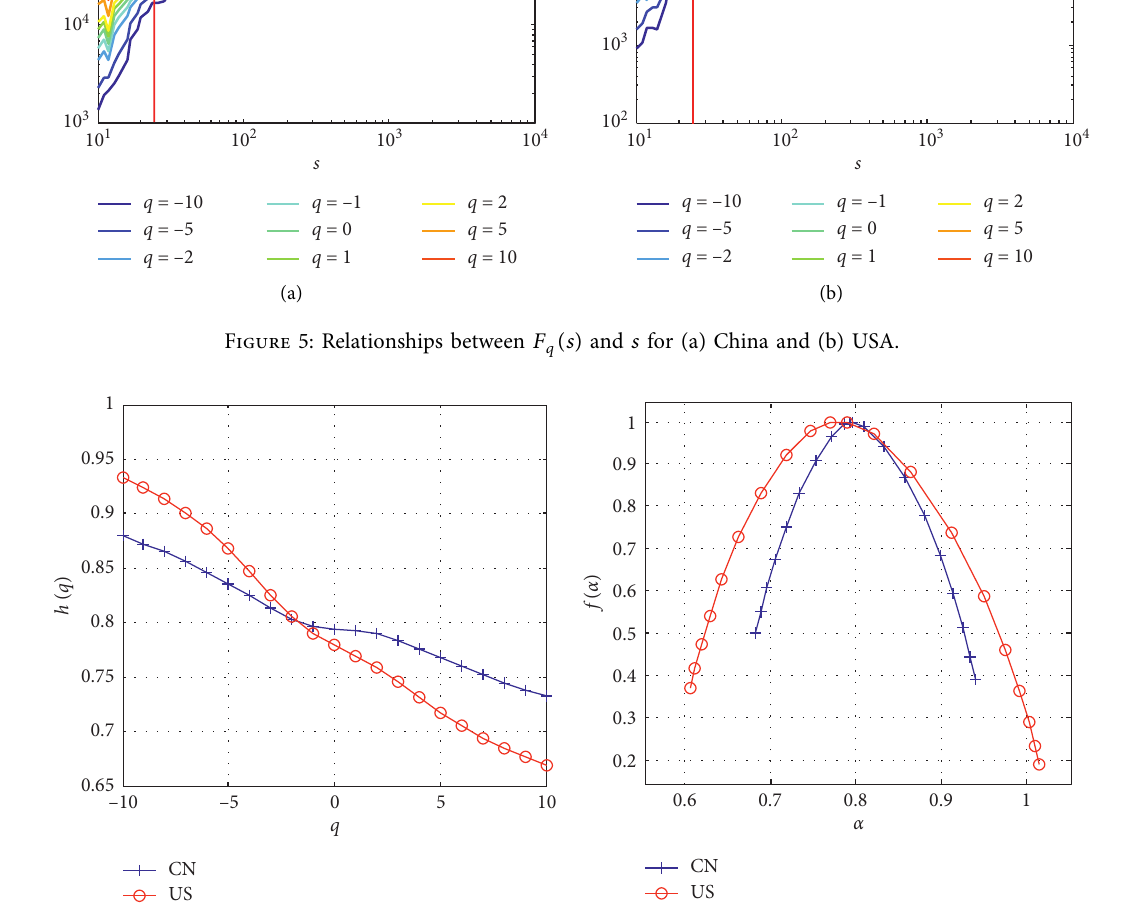
Figure 6: (a) Generalized Hurst index of flight delays series of China and USA. (b) Multifractal spectrum of China’s and USA’s flight delays